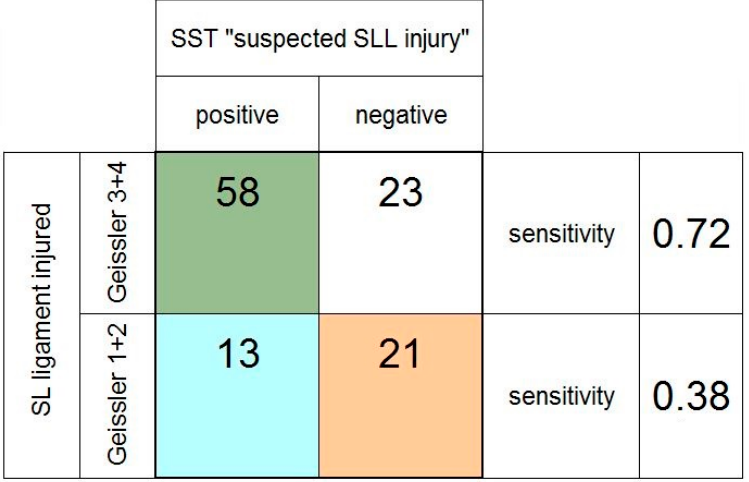
Figure 7. Fourfold table of the scaphoid shift test (SST) in the subgroup of patients referred specifically for suspected scapholunate (SL) ligament injury, depending on the severity of the SL ligament injury (grade 1 + 2 vs. grade 3 + 4, according to the Geissler classification).